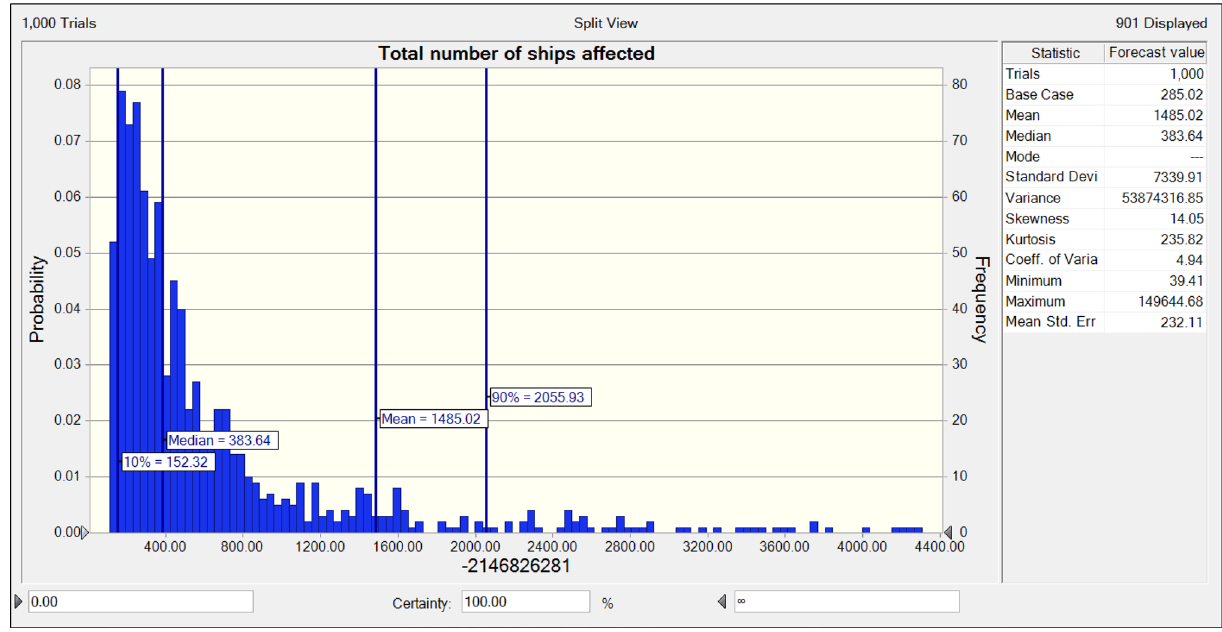
Fig. 9 Simulation results of the number of ships affected